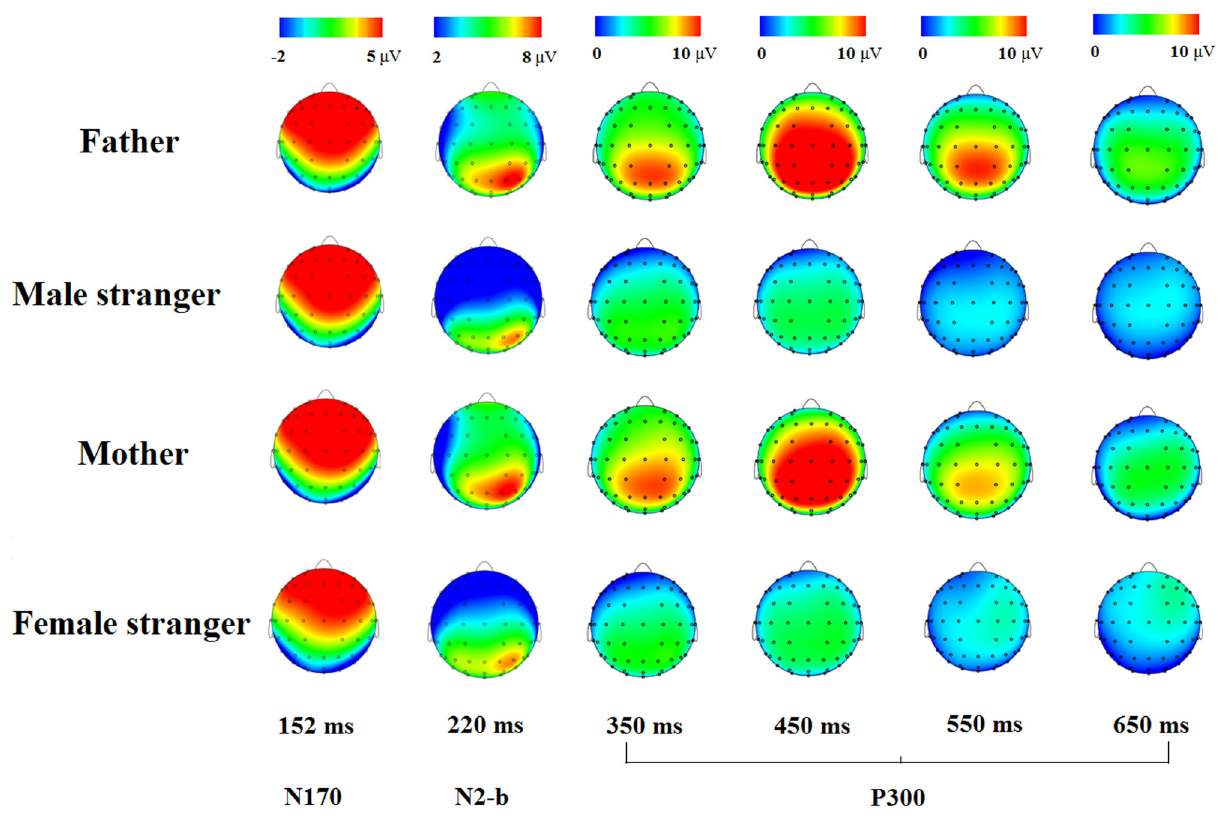
Figure 3. Scalp topography. Scalp topography of ERPs generated by the faces of the father, a male stranger, the mother and a female stranger, at different processing stages, as indicated by different time